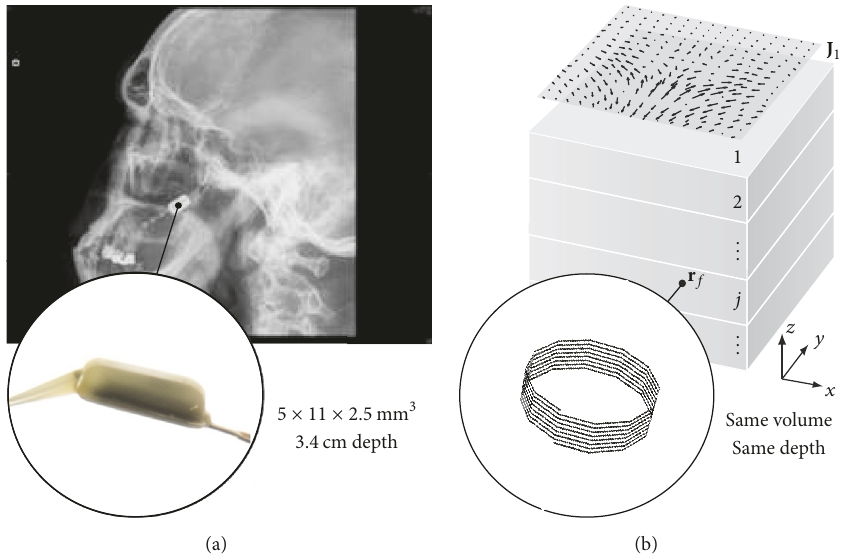
Figure 2: (a) The neurostimulator implant inside the head to relieve headache pain. (b) Modeling of the receiver occupying the same volume and in the same position as the neurostimulator implant.